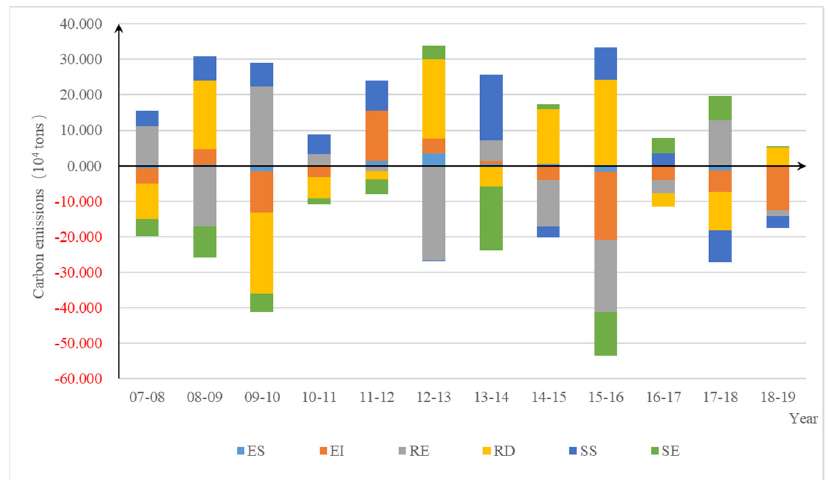
Figure 5. The catch-up effect decomposition results of carbon emissions in logistics at the national level during 2007–2019.